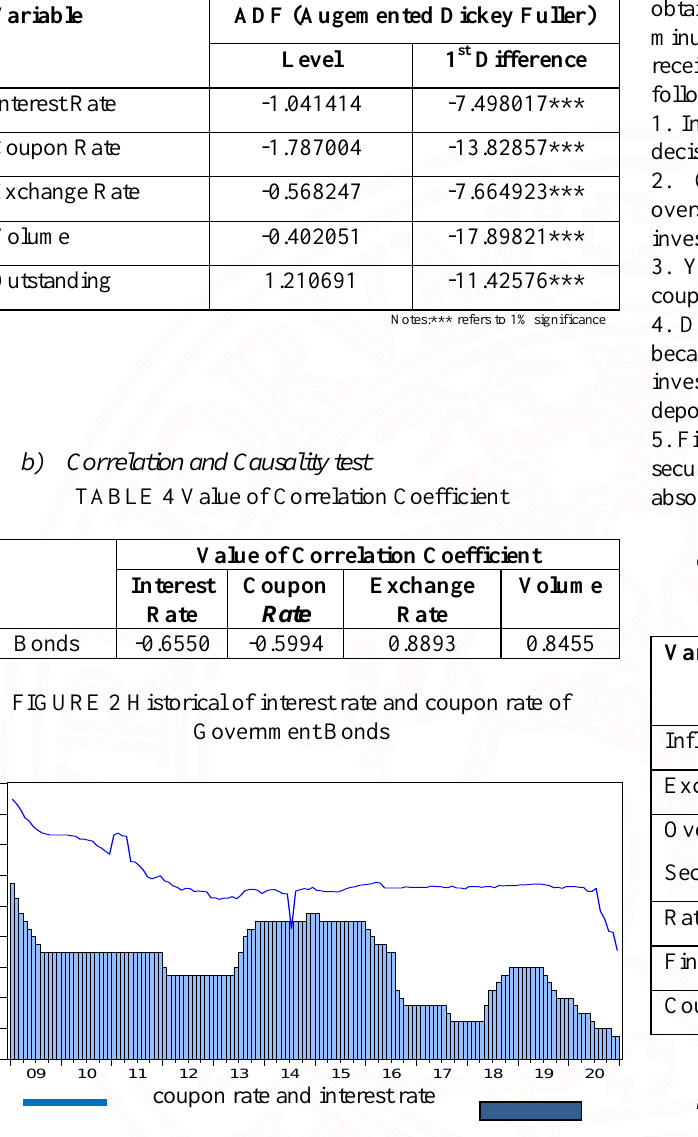
FIGURE 2 Historical of interest rate and coupon rate